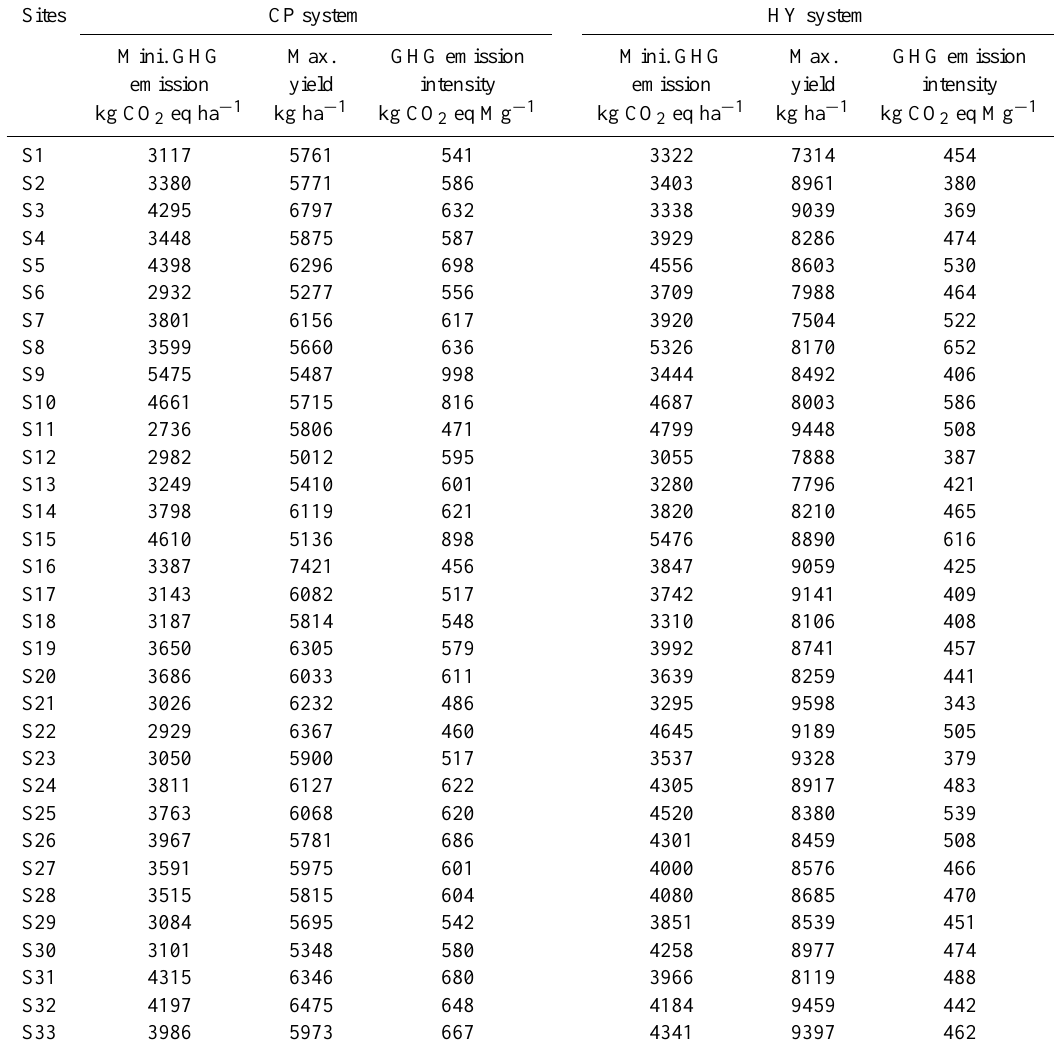
Table 2. The minimum GHG emissions needed to achieve maximum grain yield and the corresponding yields for a conventional practice (CP) and a high-yielding system